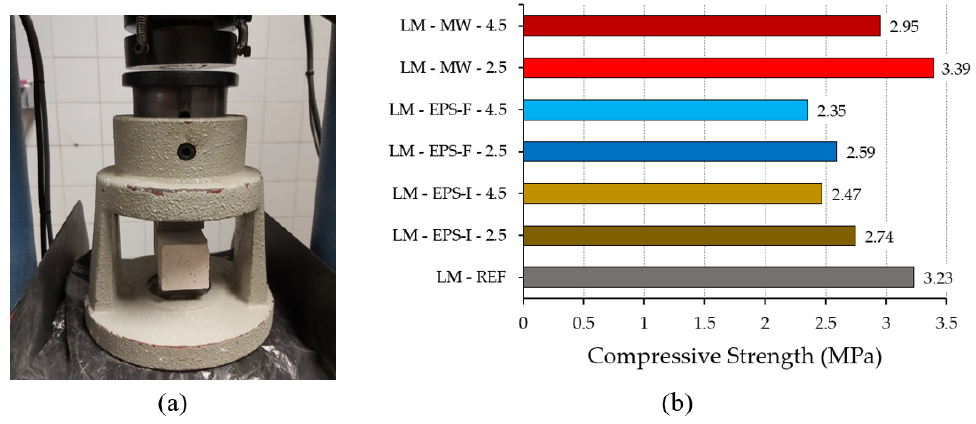
Figure 5. Compressive strength test. ( a ) IBERTEST press model AUTETEST 200-10SW; ( b ) results obtained for the different batches.